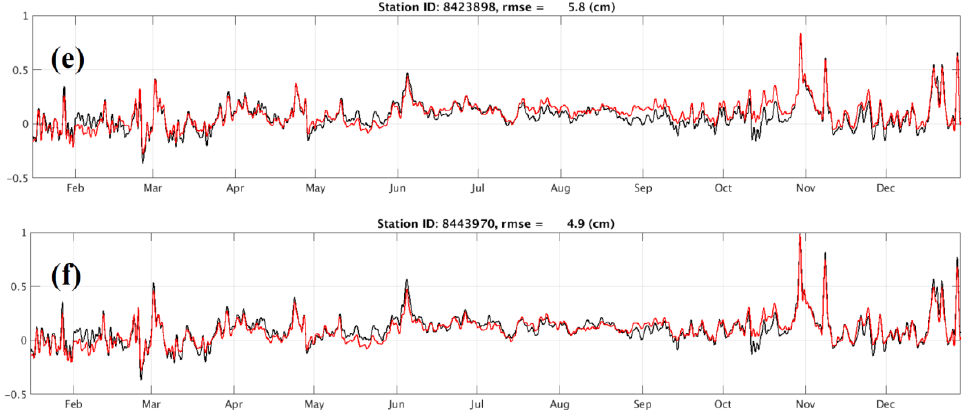
Figure 4. Subtidal water levels at six CO-OPS water level stations (Figure 1). The red and black lines represent the model results and observations, respectively. The six plots are for stations ( a ) 8411060, ( b ) 8413320, ( c ) 8418150, ( d ) 8419317, ( e ) 8423898, and ( f ) 8443970.